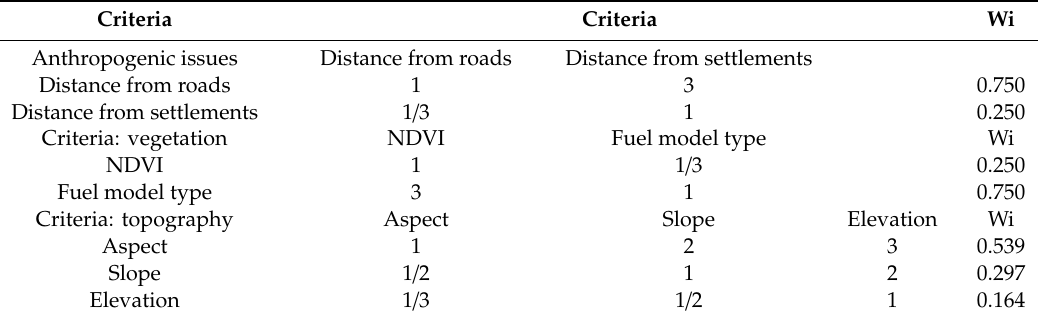
Table 5. Results of comparison matrix and weights to criteria